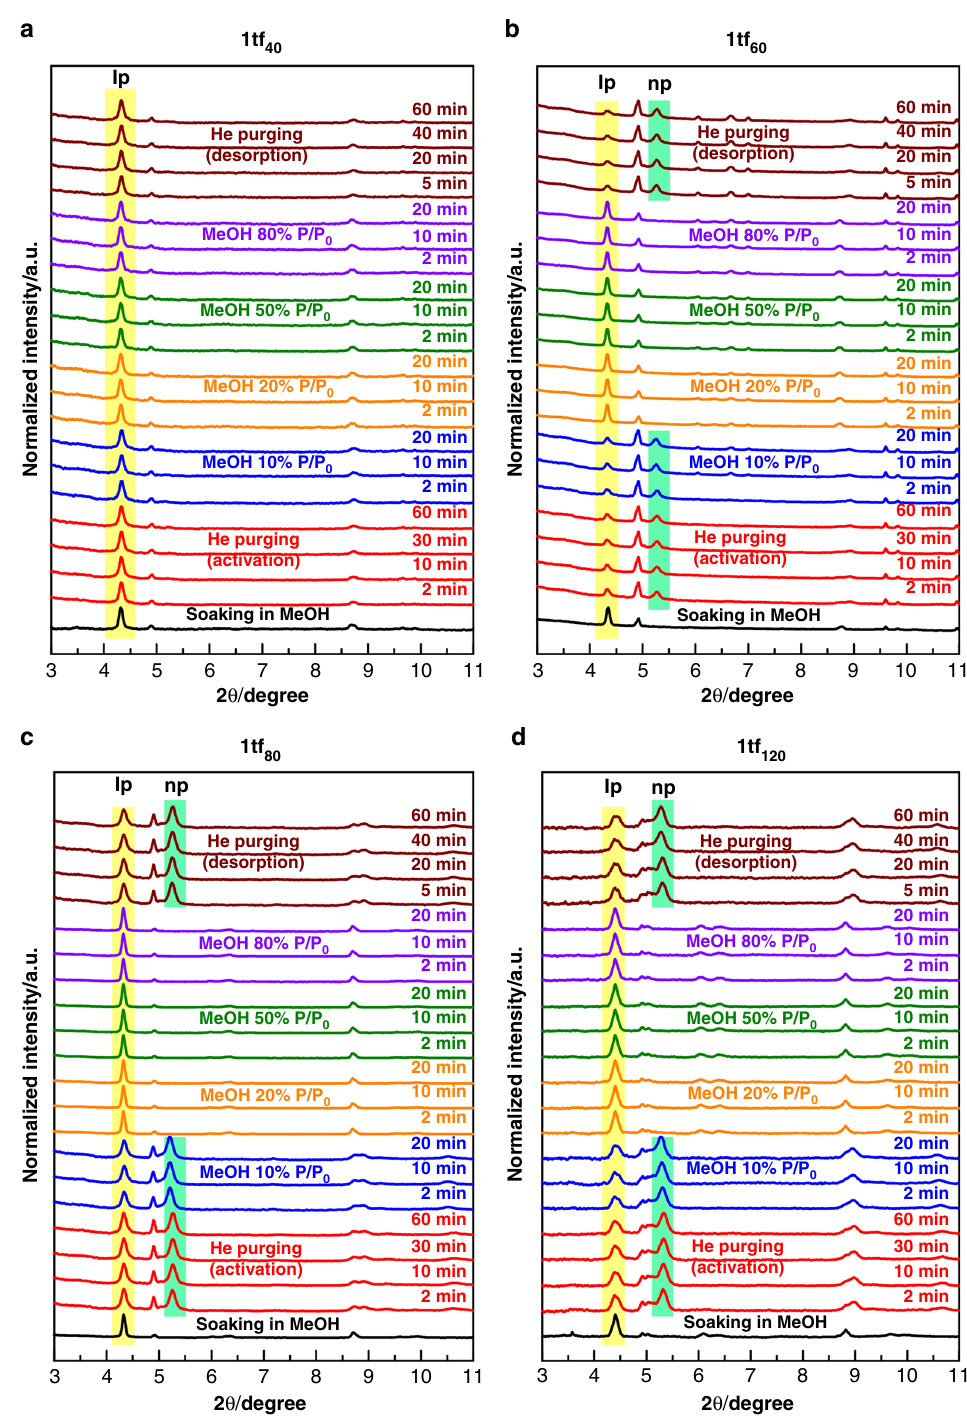
Fig. 4 Out-of-plane GIXRD pro fi les of the 1tf x materials during methanol sorption at 25 ̊ C. Herein, a 1tf 40 , b 1tf 60 , c 1tf 80 and d 1tf 120 were fabricated on — COOH functionalised QCM substrates, which show a preferred growth along the (110) plane 37 . Yellow and green highlighted bars represent the most intense diffraction peaks belonging to the lp and np phase, respectively. Herein, 1tf x exhibit a signi fi cantly different structural fl exibility upon methanol sorption than 1bulk . Moreover, a marked dependence of the structural fl exibility on the total number of fabrication cycles is observed (see also Fig. 5)